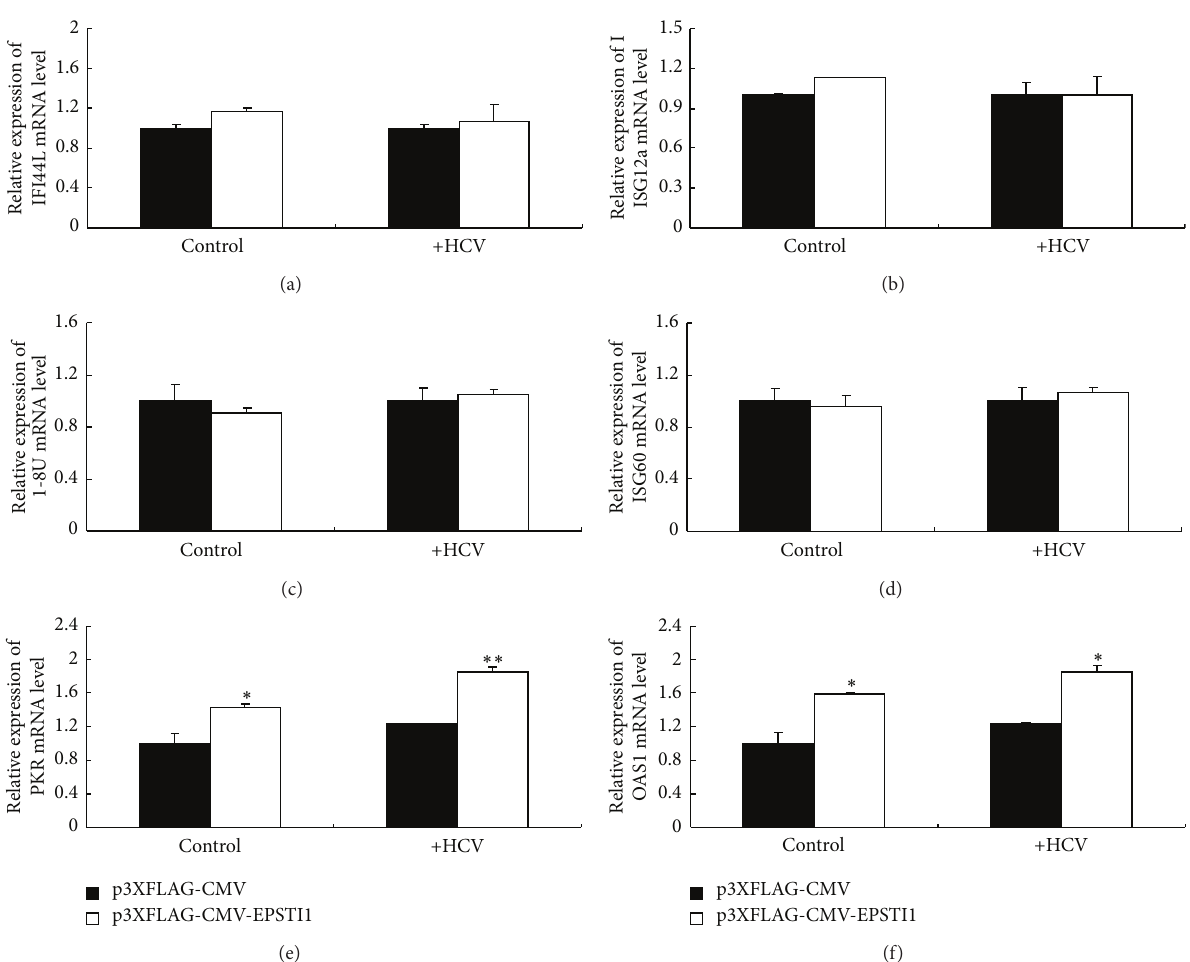
Figure 5: The regulation of ISGs by EPSTI1. Huh7.5 cells were transfected with p3XFLAG-CMV-EPSTI1 or vector followed by HCV infection (MOI = 0.1). The cells were harvested at 48 h after infection. IFI44L (a), ISG12a (b), 1-8U (c), ISG60 (d), PKR (e), and OAS1 (f) mRNA were detected by real-time PCR and normalized with